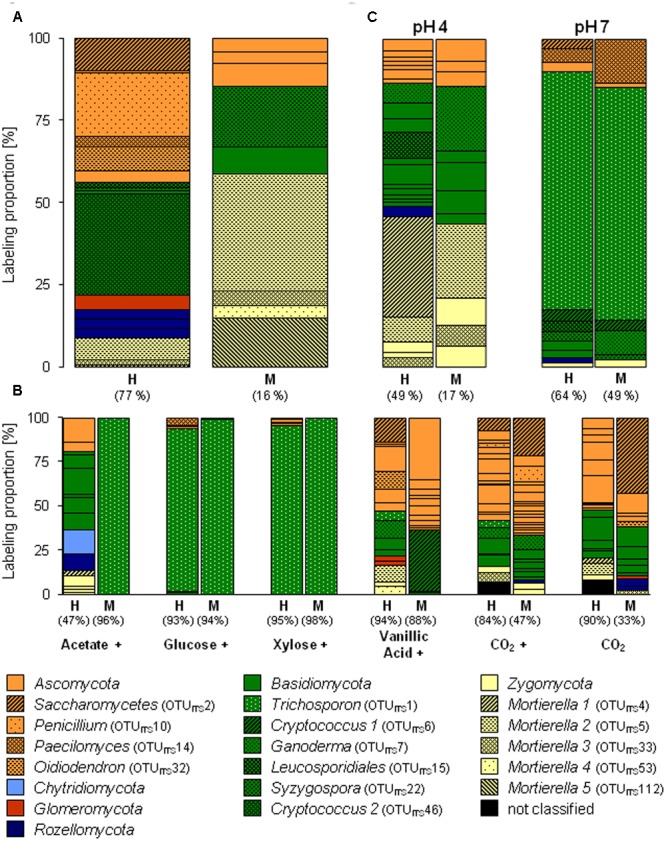
Labeling proportions and identities of fungal ITS phylotypes in the ‘heavy’ and ‘middle’ fractions of [13C1]-methanol (A) and different [13Cu]-substrates (B) treatments of the substrate SIP experiment, and of the treatments of the pH SIP experiment (C). Cross, additional [12C]-methanol supplementation in substrate treatments. Equal colors, the same phylum affiliation. ‘H’ and ‘M,’ ‘heavy’ and ‘middle’ fractions, respectively. Values in brackets, contribution of labeled OTUs to the total number of sequences. The ‘labeling proportions’ are indicators for the relative importance of different taxa assimilating the supplemented 13C (directly or indirectly).